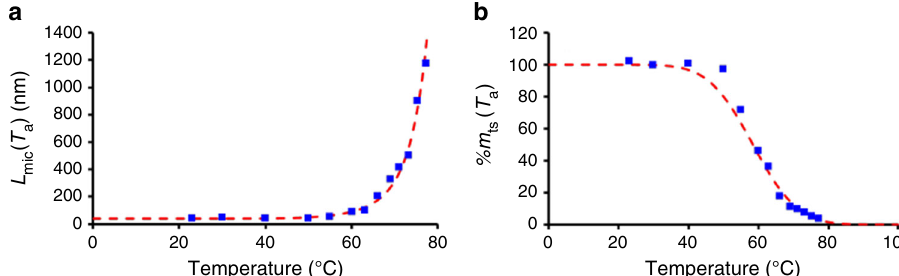
Fig. 4 Fitting of the length of micelles obtained by self-seeding. a Fit (eq. 6, dashed line) of the number average length of the PFS 53 - b -PI 637 seed crystallites regrown at 23 °C ( fi lled squares) as a function of annealing temperature (control experiment). b Fit (dashed line) of the apparent mass percentage of surviving seeds as a function of annealing temperature ( fi